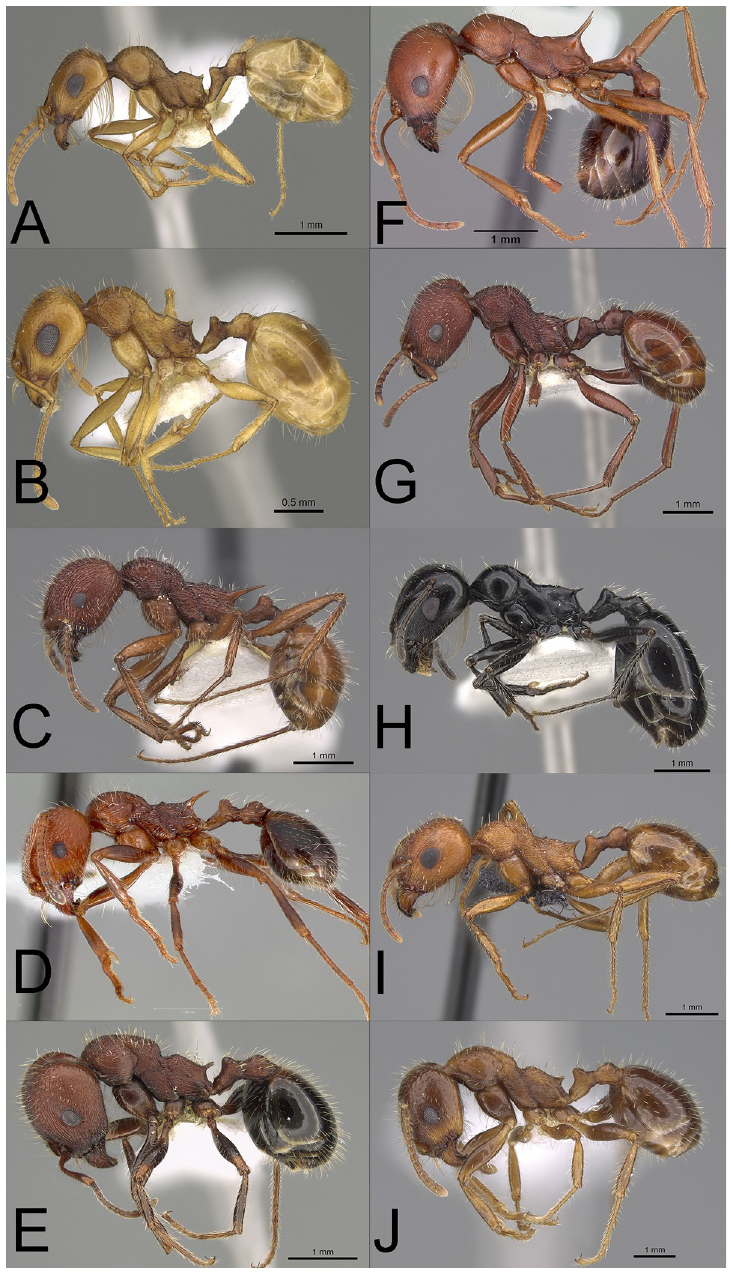
Fig 4. Profile photographs of pale (A–B) and dark species (C–J) (see text) of Veromessor (subfamily Myrmicinae) examined in this study: ( A ) V . lariversi (CASENT0923345), ( B ) V . RAJ- pseu (CASENT0923346), ( C ) V . andrei (CASENT0923137), ( D ) V . chamberlini (CASENT0005730), ( E ) V . chicoensis (CASENT0923347), ( F ) V . julianus (CASENT0104946), ( G ) V . lobognathus (CASENT0923126), ( H ) V . pergandei (CASENT0923124, ( I ) V . smithi (MCZ-ENT00671466), and ( J ) V . stoddardi (CASENT0922825). Note the relatively larger eyes of pale compared to dark species. Photographs by Wade Lee, April Nobile, and Michele Esposito from